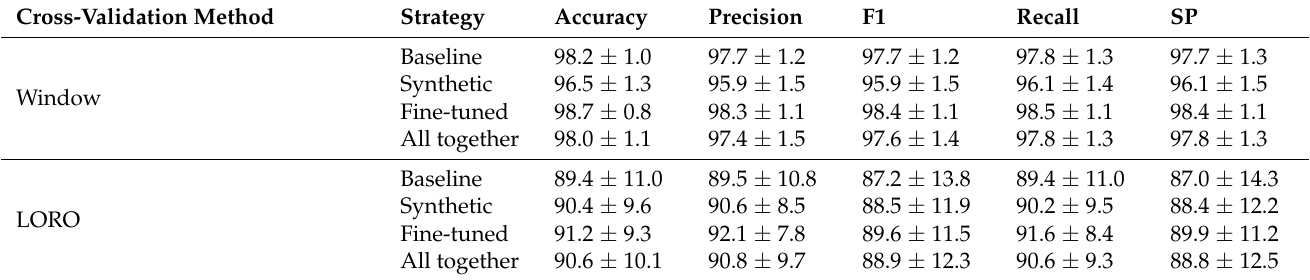
Table 8. Figures of merit for all design strategies measured from the window-based and LORO cross-validation methods for the MaxPro approach. Synthetic data generated with the cGAN.